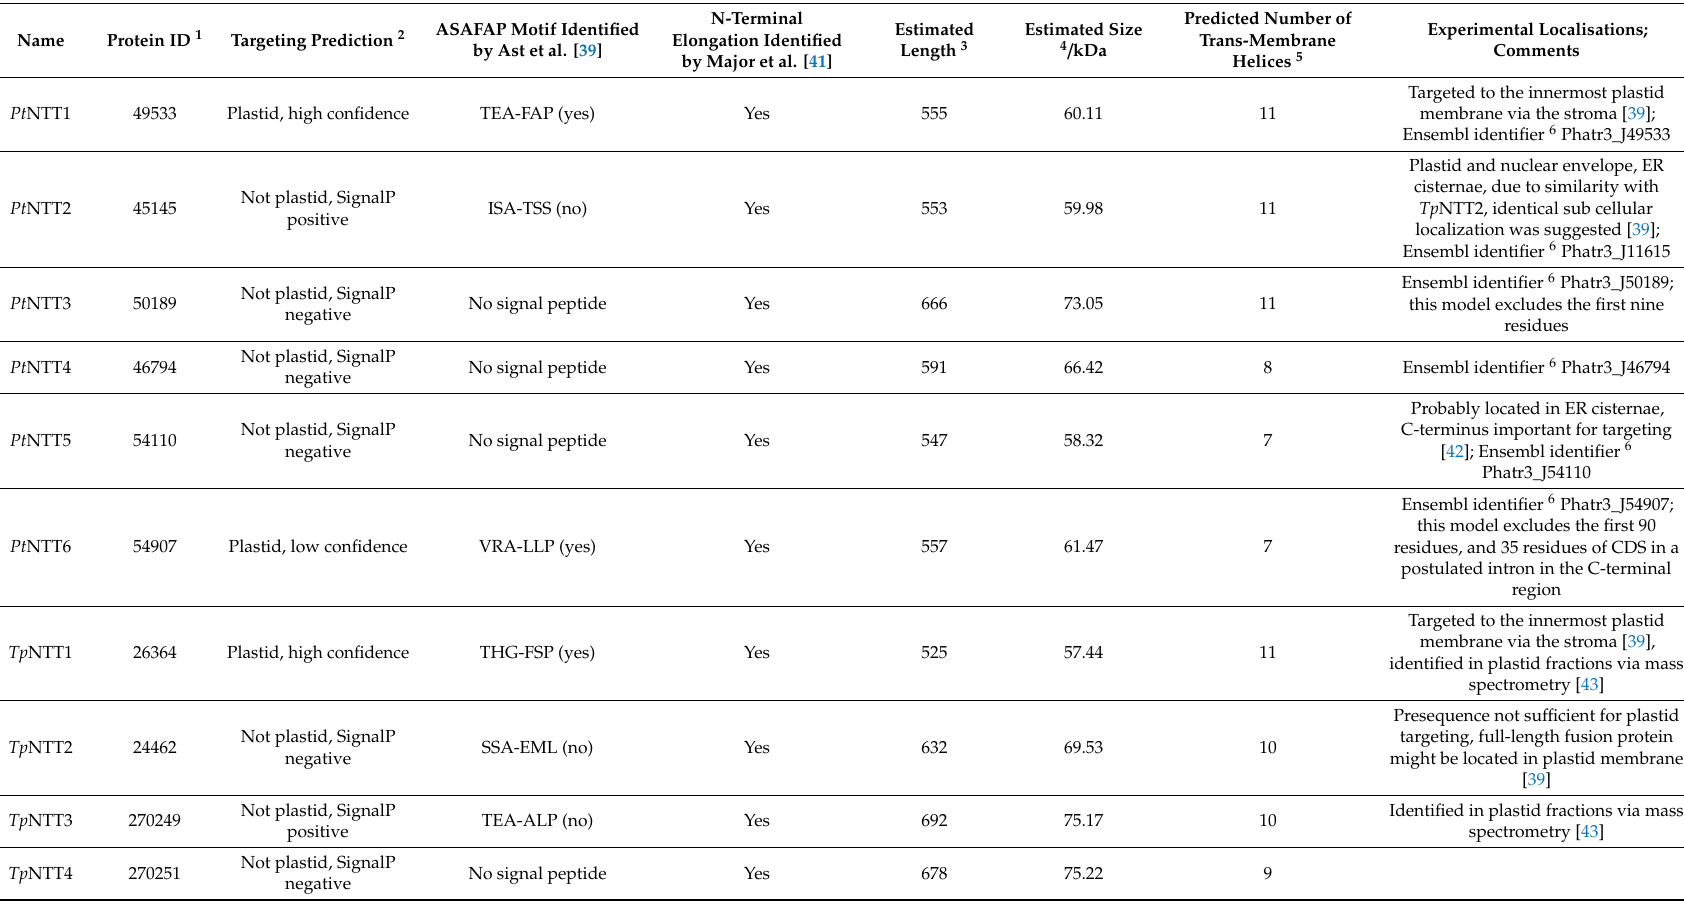
Table 1. Sequence properties, targeting predictions, and experimental localisations of diatom nucleotide transporters